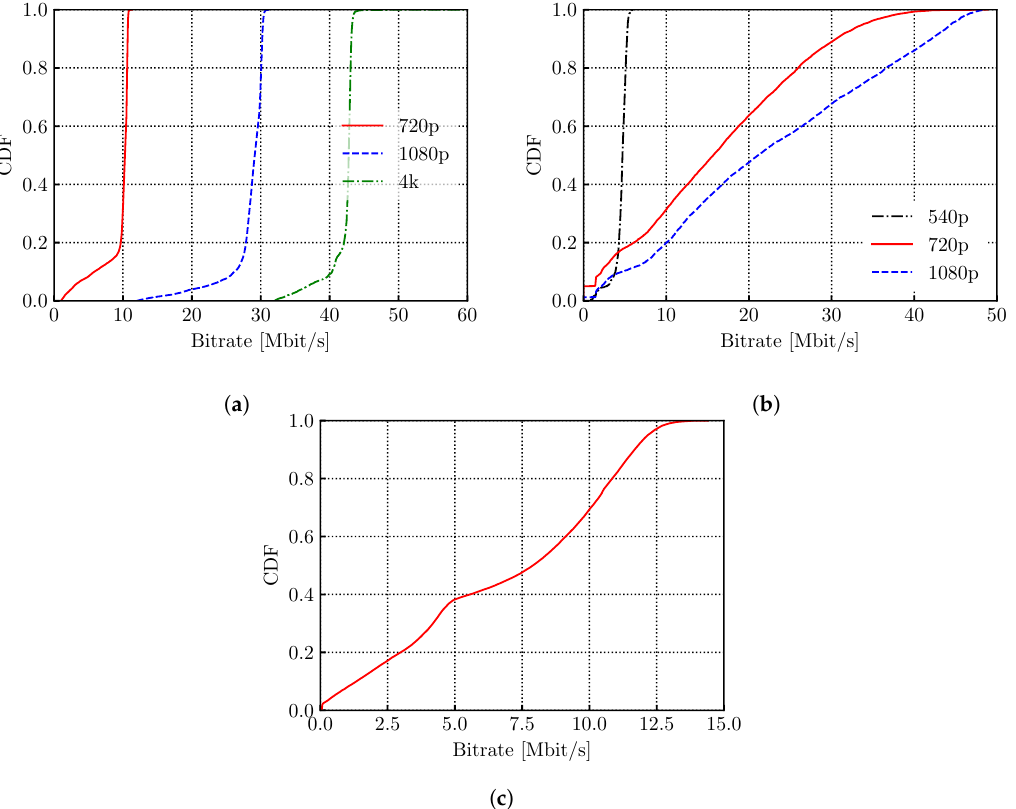
Figure 3. Cumulative distribution of the video bitrate, for different quality video levels. ( a ) Stadia . ( b ) GeForce Now . ( c ) PS Now